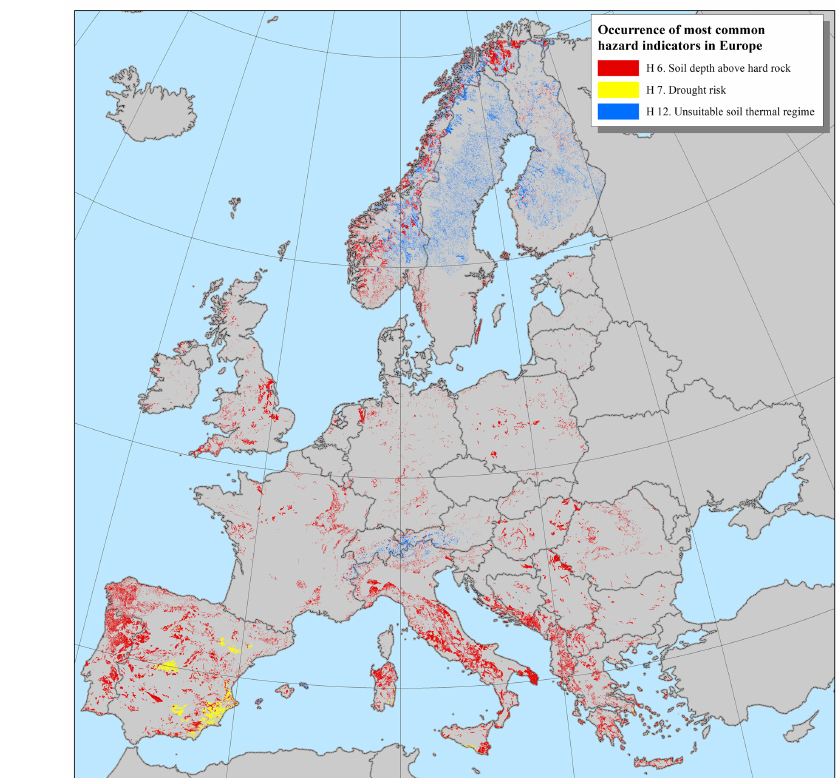
Figure 11. Occurrence of the most common hazard indicators (H 6, H 7, and H 12) in Europe.